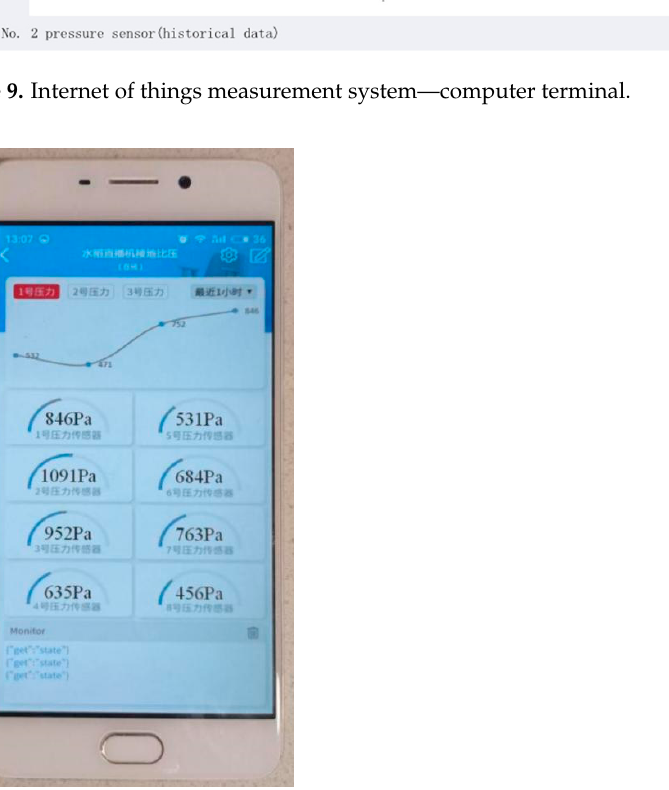
Figure 9. Internet of things measurement system—computer terminal.